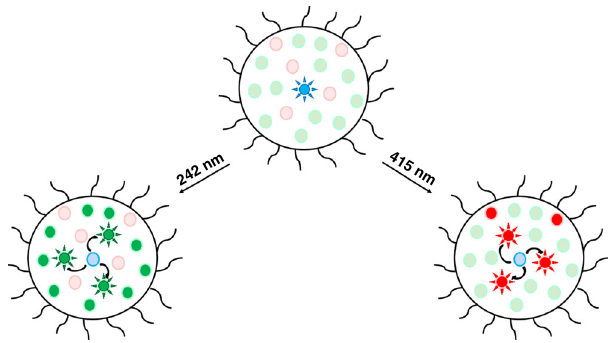
Fig. 2 Schematic depiction of the micelle cocktail approach used in this study. Curved arrows indicate the orthogonally controlled FRET processes, responsible for the emission color changes